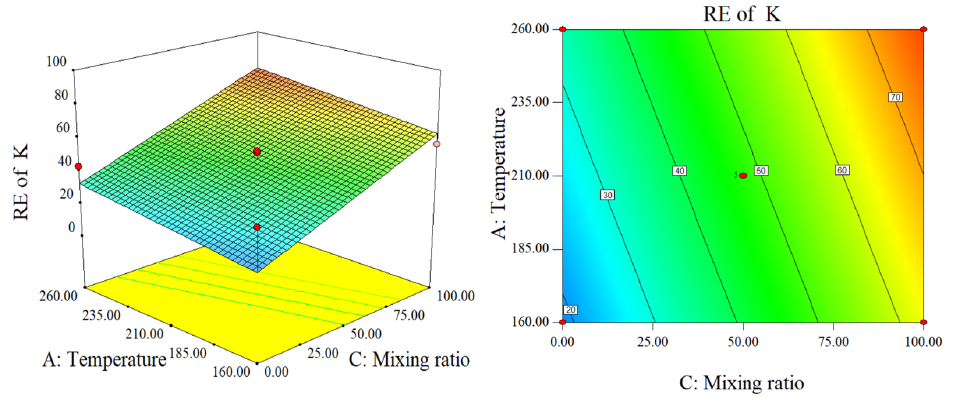
Figure 5. Response surface plots and contour plots of RE of K.